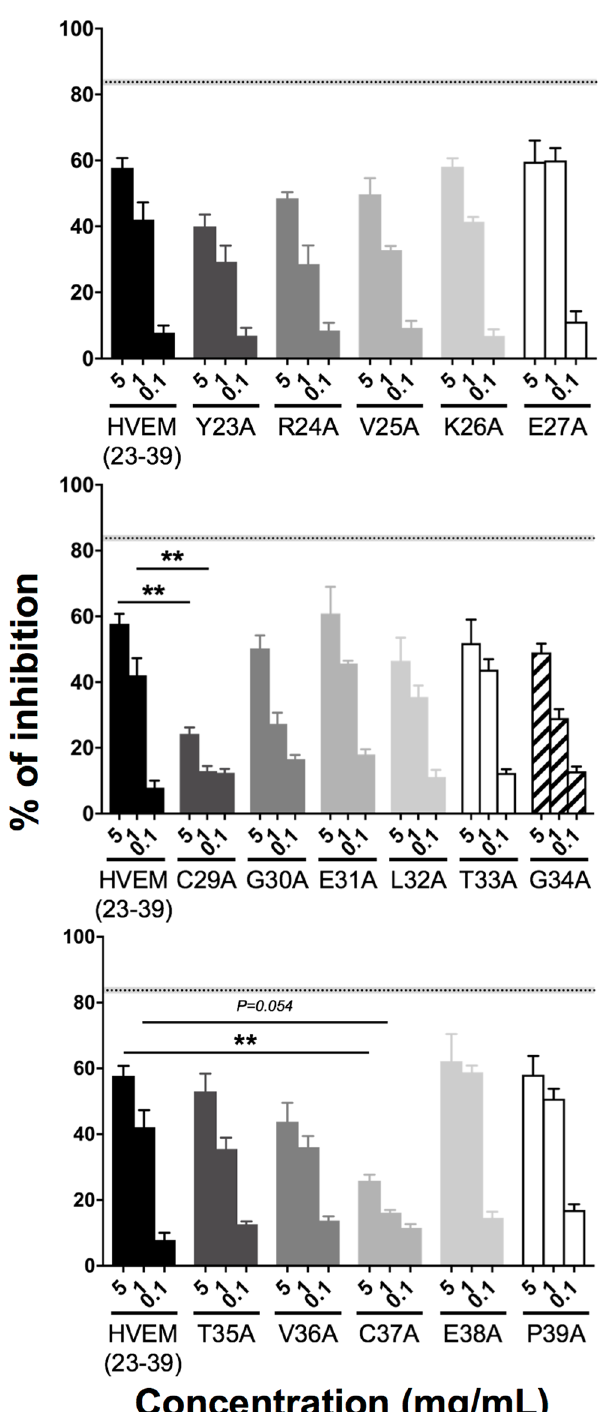
Fig 4. Contribution of individual HVEM(23–39) amino acid residues to the inhibition of BTLA/HVEM interaction. The relative involvement of alanine-substituted HVEM(23–39) peptideanalogswas assessed by ELISA (at least two experiments in triplicate) in the presenceof gradedpeptideconcentrations (5, 1 and 0.1 mg/mL). The percentageof inhibitionof the BTLA/HVEM bindingwas calculatedin relationto the negative control (PBS). The gray and dotted back lines correspond to the percentages of inhibitionobservedwith an anti-BTLA blockingantibody(Mean +/-SEM). Statistical analysiswas performed by comparing each concentration of modifiedpeptideto the same concentration of wild-typepeptideHVEM(23–39). ** : p < 0.01 followingnon-parametric One-way ANOVA and Dunn’spost-test.